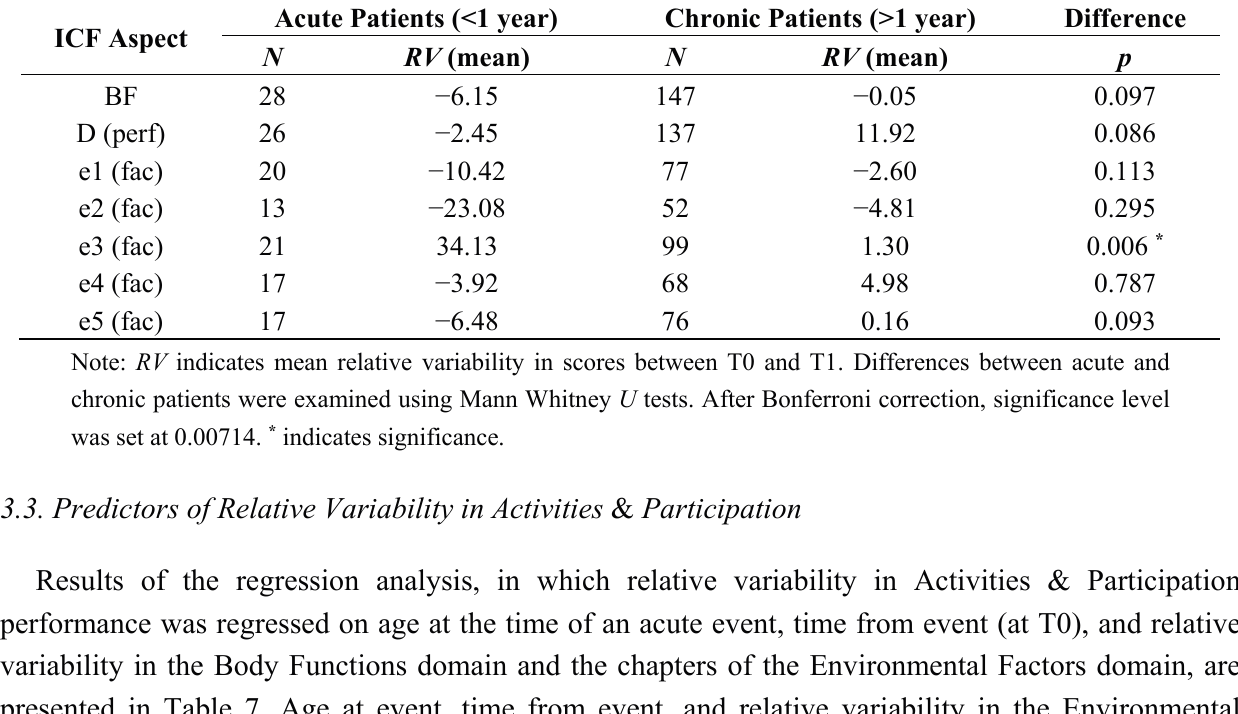
Table 6. Comparison of relative variability in International Classification of Functioning, Disability, and Health domains in acute vs. chronic patients. ICF